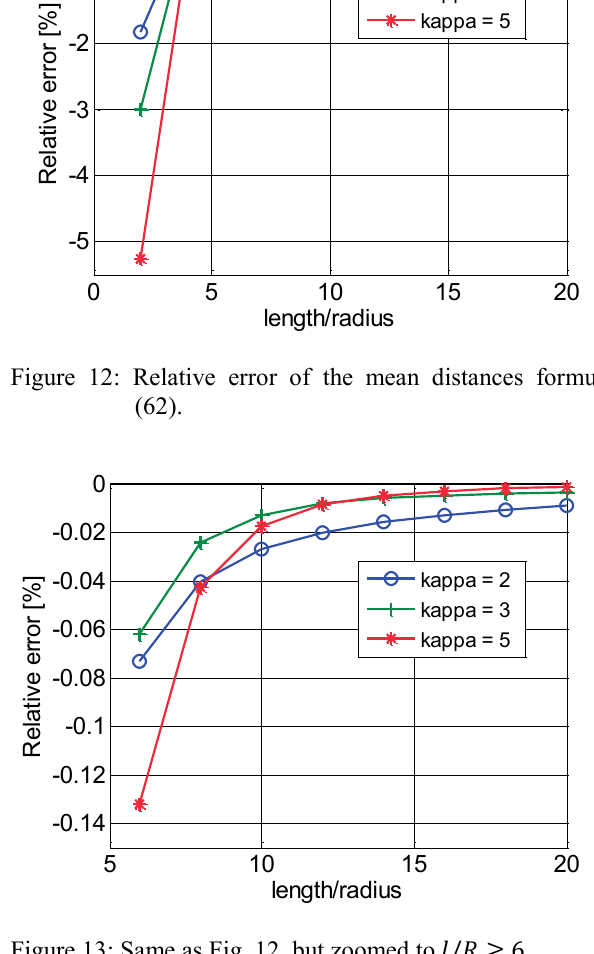
Figure 13: Same as Fig. 12, but zoomed to .